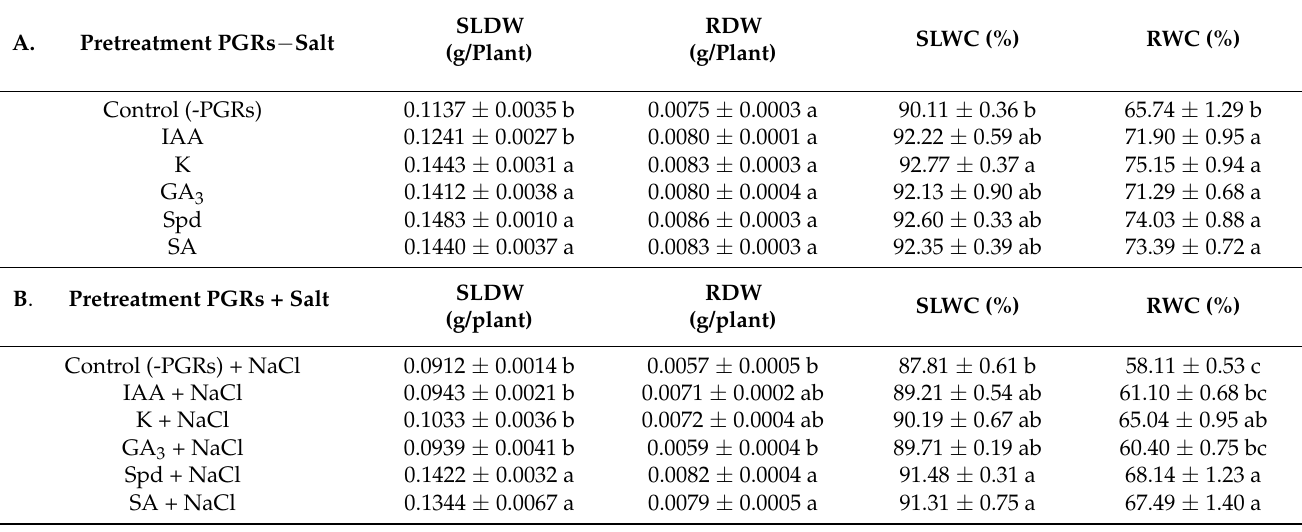
Table 1. ( A ) Effect of pretreatment PGRs (plant growth regulators) under non-saline conditions, and 1 ( B ) pretreatment PGRs with salt (300 mM NaCl) in Frankenia pulverulenta , at 52 days of culture on SLDW (stem + leaves dry weight), RDW (root dry weight), SLWC (stem + leaves water content), and roots water content (RWC). The values represent means ± SE ( n = 16). Different letters next to column represent significant differences between treatments, according to Tukey’s test ( p ≤ 0.05). A.